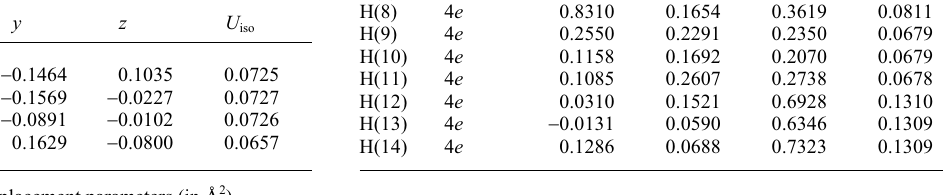
Table 2. Atomic coordinates and displacement parameters (in Å 2 ) .